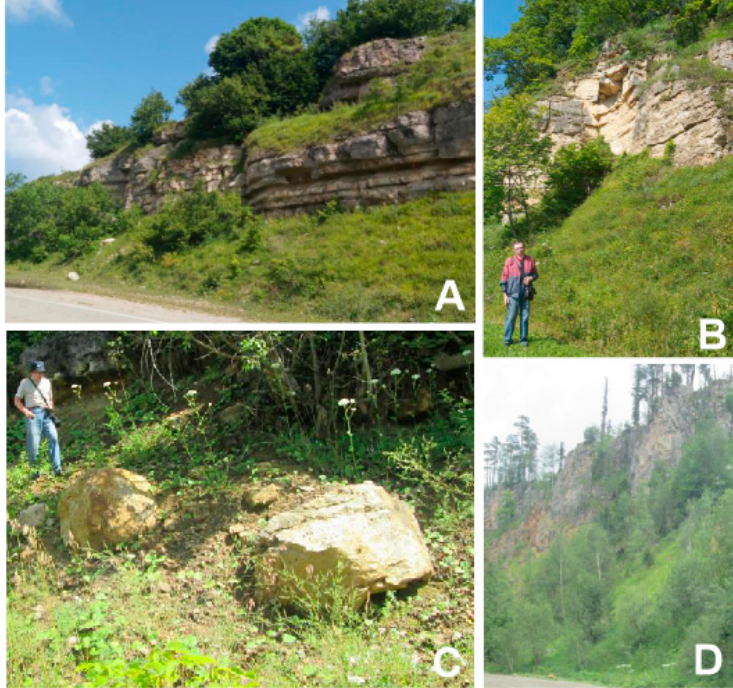
Figure 2. The studied localities: ( A ) Tender Cave, ( B ) 5000, ( C ) Partisan Glade, and ( D ) Azish Cave.